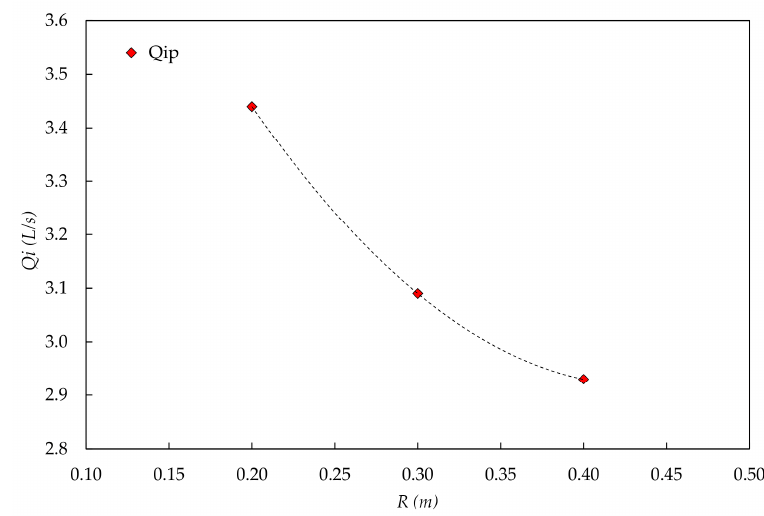
Figure 15. Flow rate for the initiation of the jet flow, obtained by the proposed methodology and formula for different values of R , Qi p , for a constant value of z = 0.054 m.